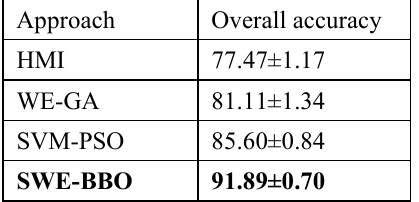
Table 8. Comparison with other